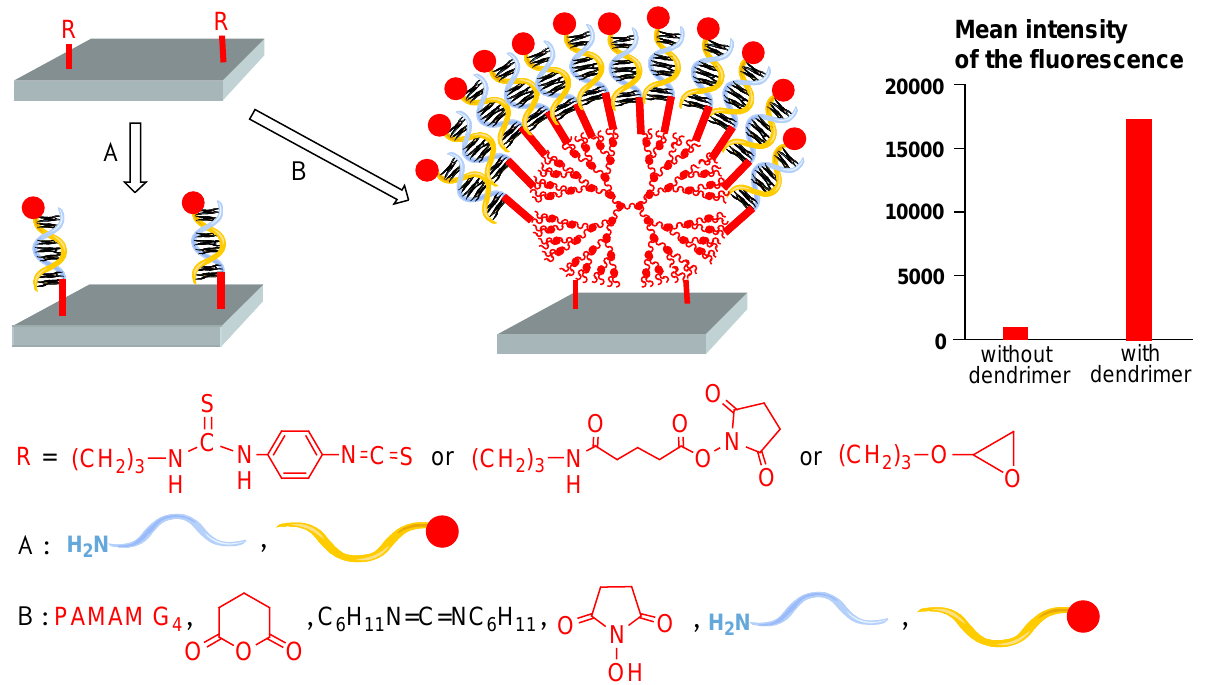
Figure 5. Comparison of the fluorescence intensity measured after hybridization with a fluorescent labeled oligonucleotide on a "classical" surface and on a surface modified by PAMAM